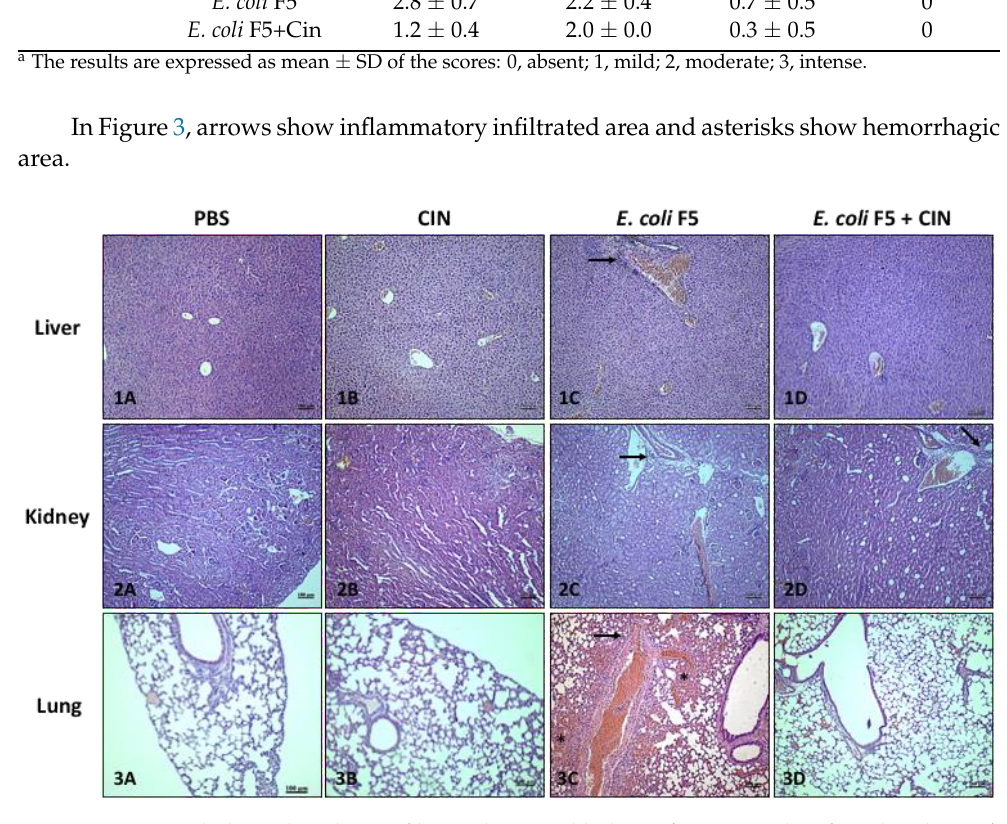
Figure 3. Histopathological analyzes of lungs, liver, and kidneys from animals infected with E. coli F5 and cinnamaldehyde treatment. Ten hours after peritoneal inoculation of E. coli F5, the organs of the animals were removed for histopathological analysis. Liver: ( 1A ) PBS; ( 1B ) CIN; ( 1C ) E. coli F5; ( 1D ) E. coli F5+CIN. Kidney: ( 2A ) PBS; ( 2B ) CIN; ( 2C ) E. coli F5; ( 2D ) E. coli F5+CIN. Lung: ( 3A ) PBS;